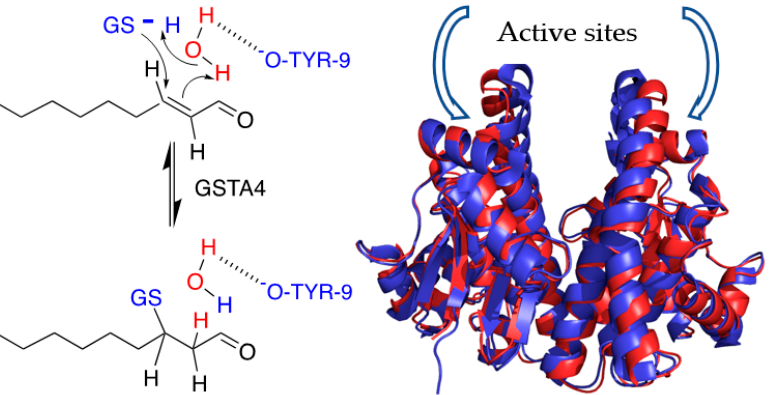
Figure 2. ( Left ): Proposed mechanism for GSH reaction with NE. The active site Tyrosine-9 (Tyr-9) is acidic and remains unprotonated. GSH is initially protonated in contrast to other GSTA isoforms. ( Right ): Superimposition of ligand-free GSTA4-4 (red, PDB1GUL) and GSTA1-1 (blue, PDB1K3L). Each monomer has an active site.